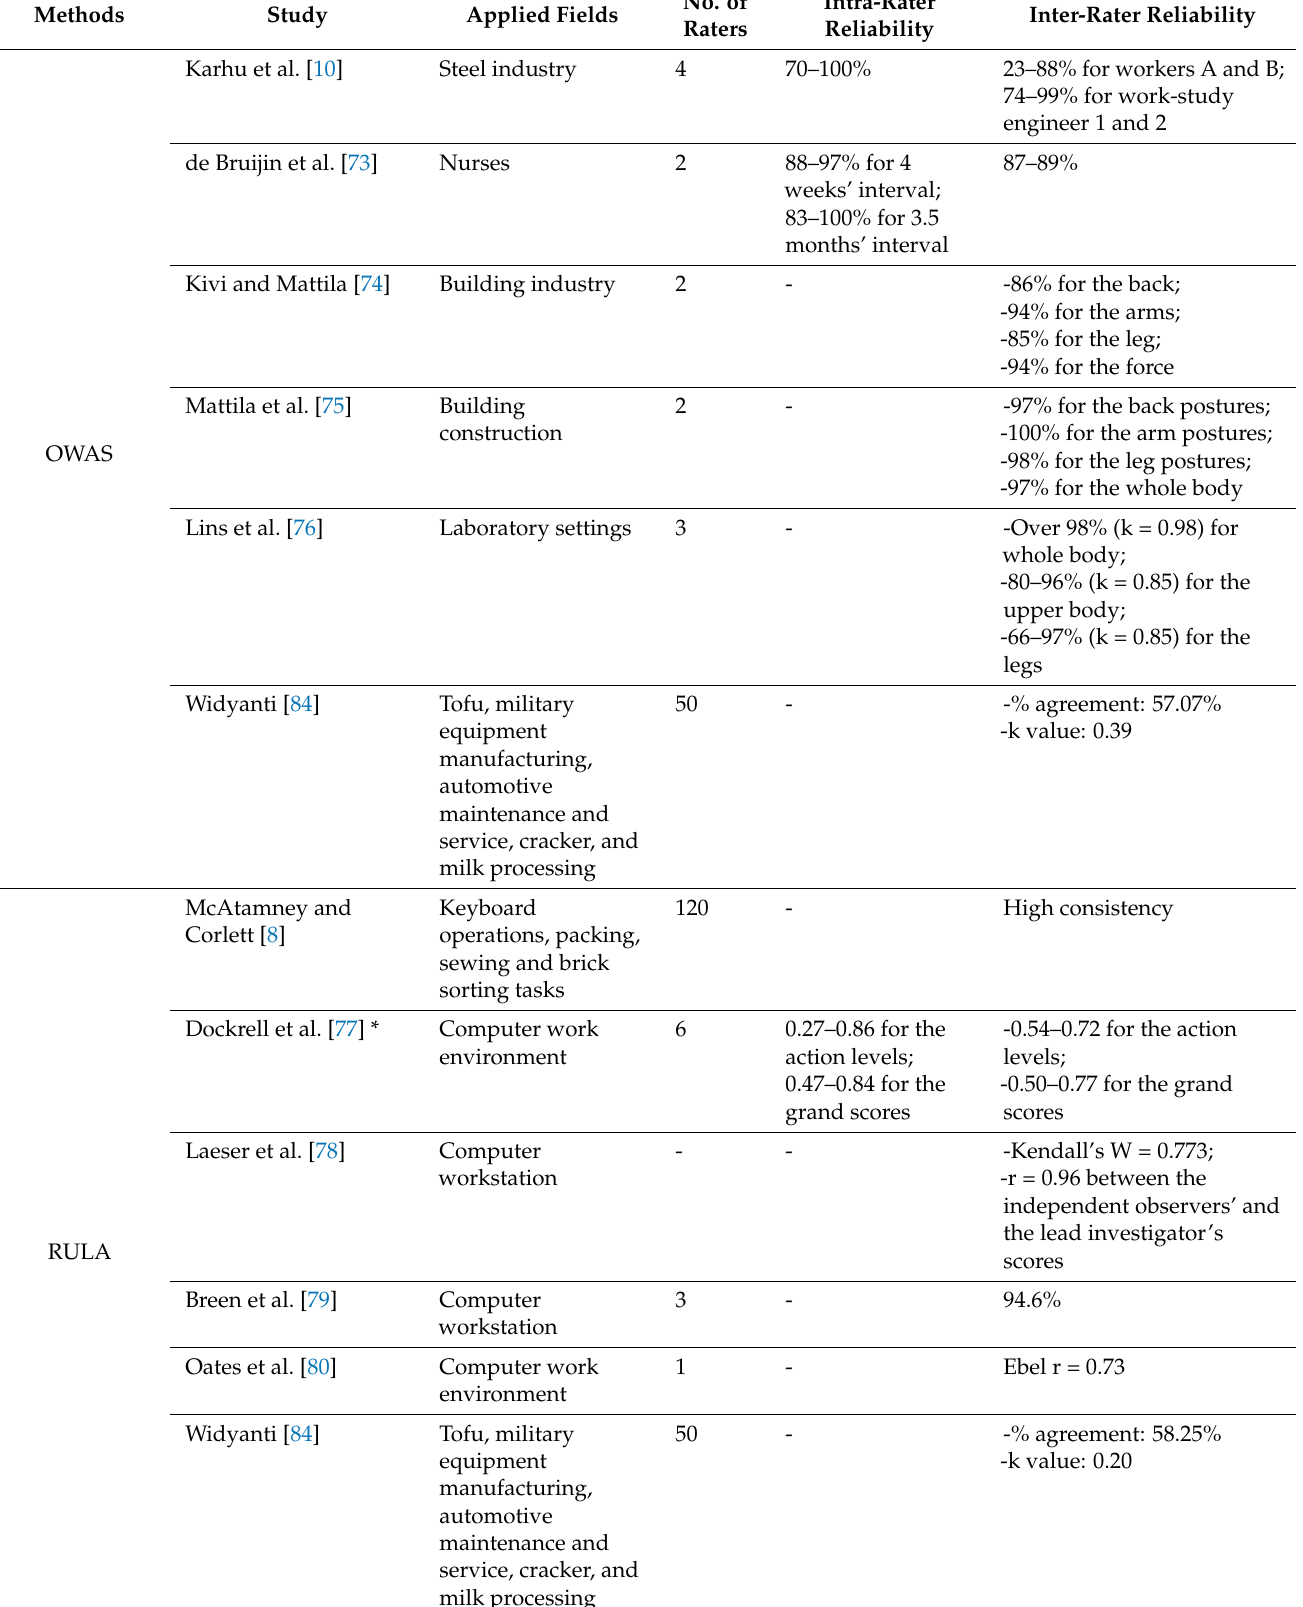
Table 5. Intra- and inter-rater reliabilities by